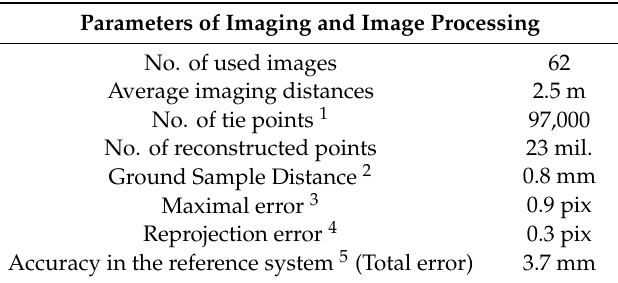
Figure 12. Final photo-textured point cloud from the photogrammetric imaging and processing. Table 1. Parameters of imaging and image processing in APSC, Version 1.2